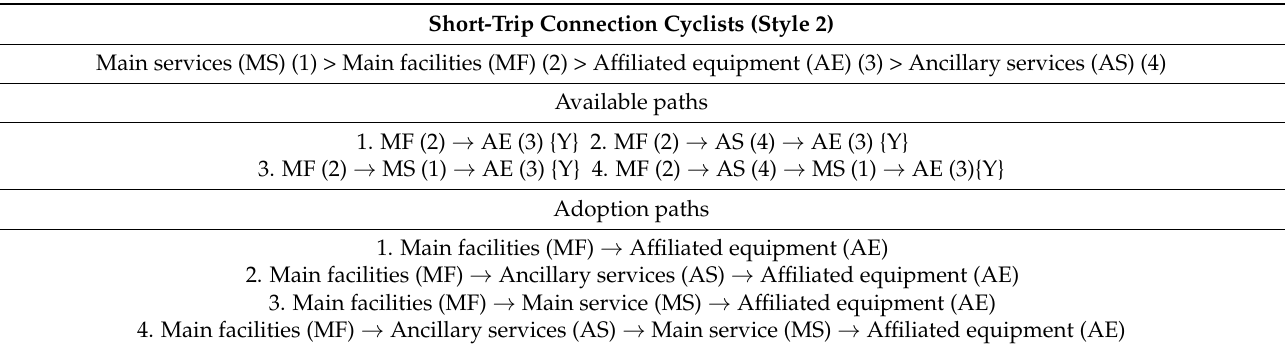
Table 21. The adoption paths of short-trip connection cyclists (Style 2). Short-Trip Connection Cyclists (Style